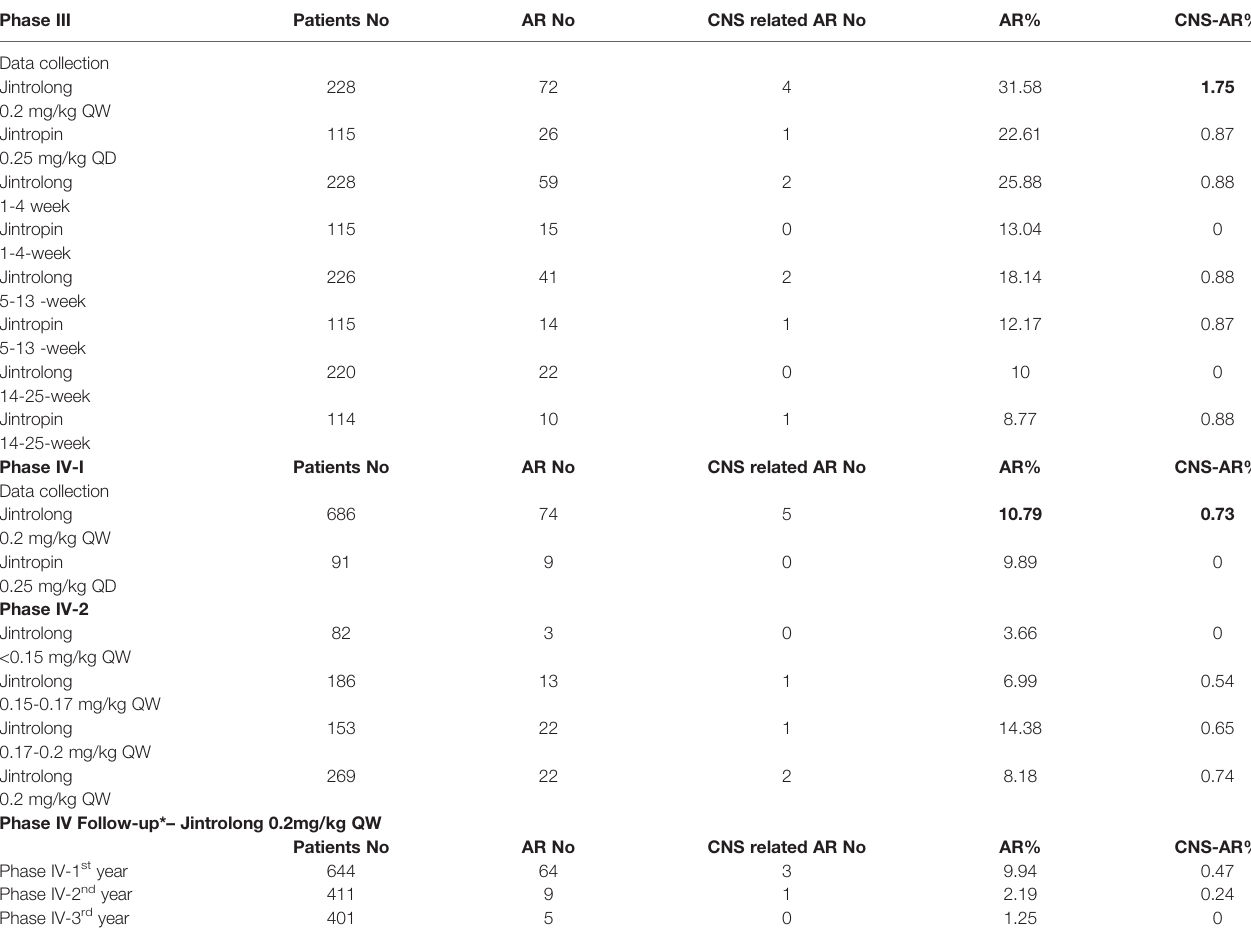
TABLE 6 | Adverse reactions(ARs) reports analysis in clinical